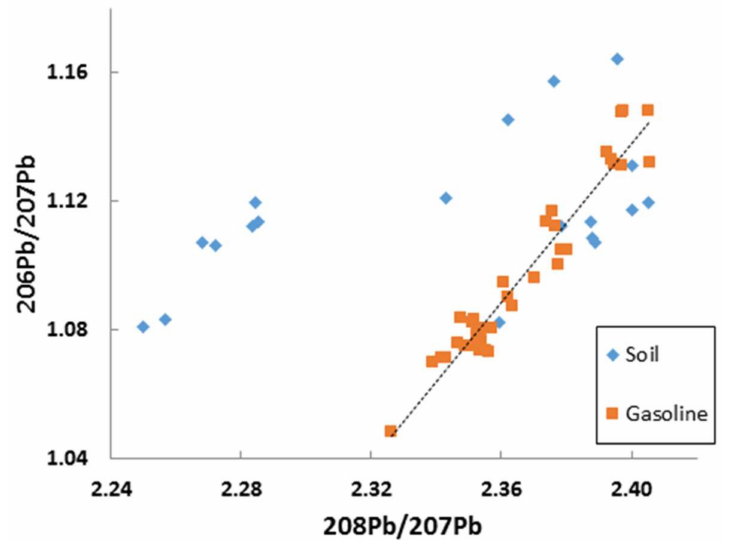
Figure 12. Major isotope ratio plot showing displacement of most of the soil data arising from analytical problems with